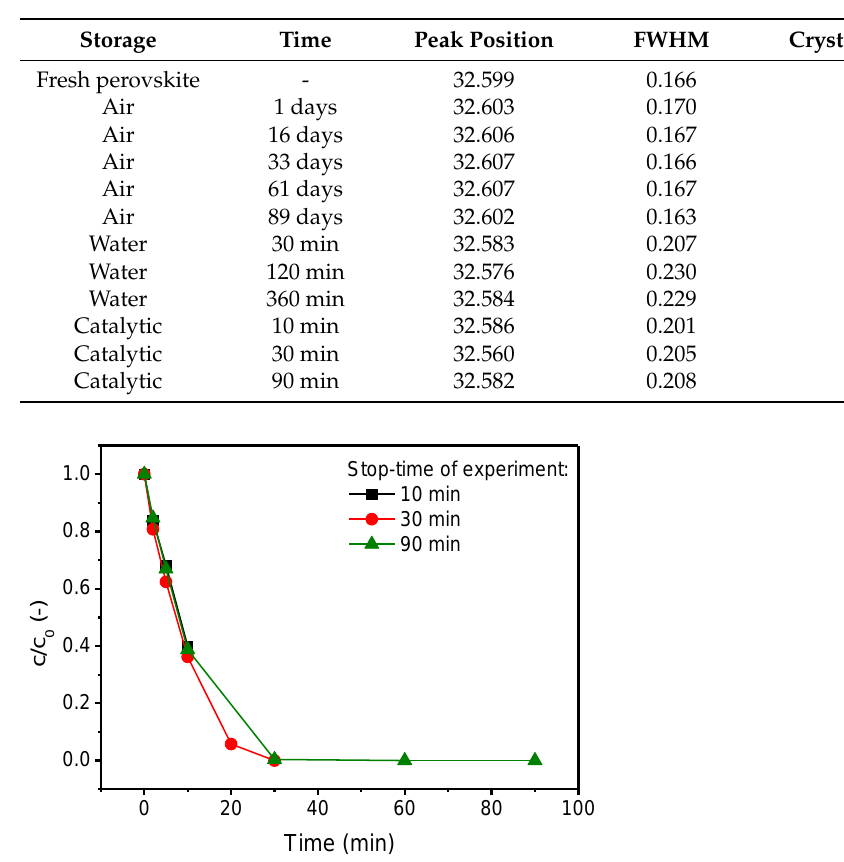
Table 1. Peak position and full width half maxima (FWHM) of most dominant SCF peak at 2 θ = 32.6 for calculation of crystallite size.